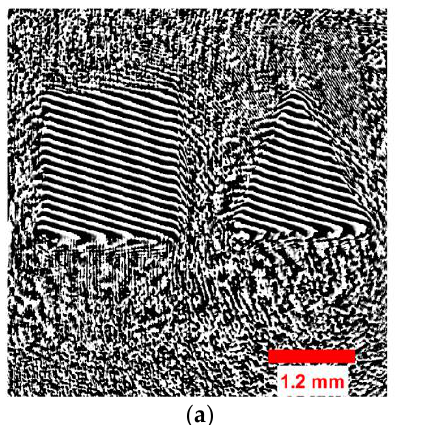
Figure 5. ( a ) Concatenated intensity – phase image of the circle – pentagon ( 𝑅𝑎 𝑑1,𝐼𝑁𝑃𝐻 ) object that belonged to Class-a; ( b ) concatenated intensity – phase image of the square – rectangle ( 𝑅ℎ 𝑑1,𝐼𝑁𝑃𝐻 ) object that belonged to Class-b.